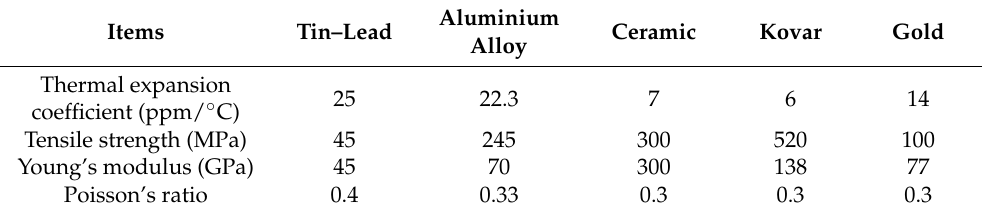
Table 1. Physical parameters of materials.